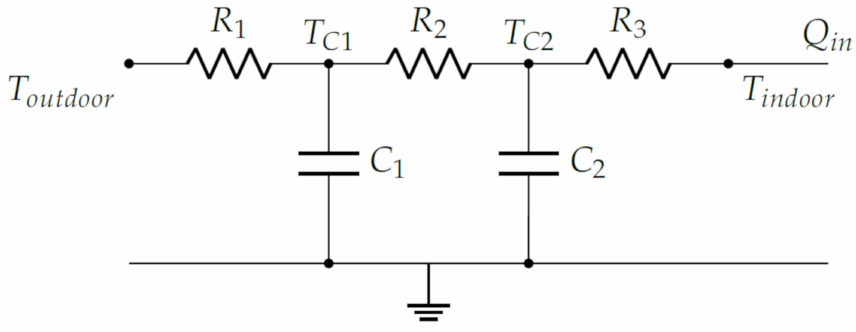
Figure 2. Simplified thermal network model -